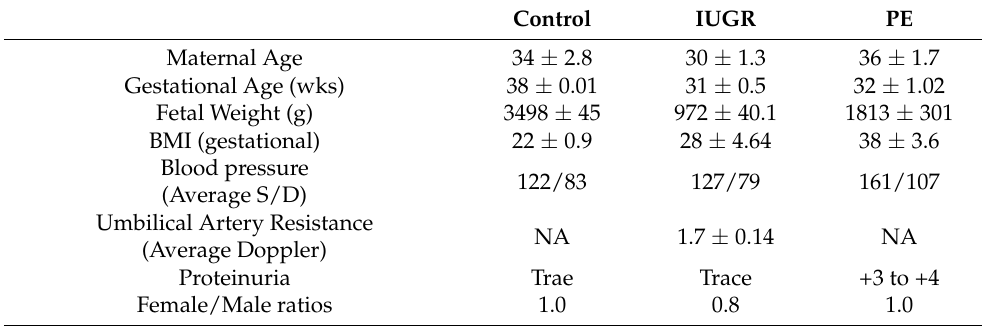
Table 1. Demographical and clinical patient data from the collected placental